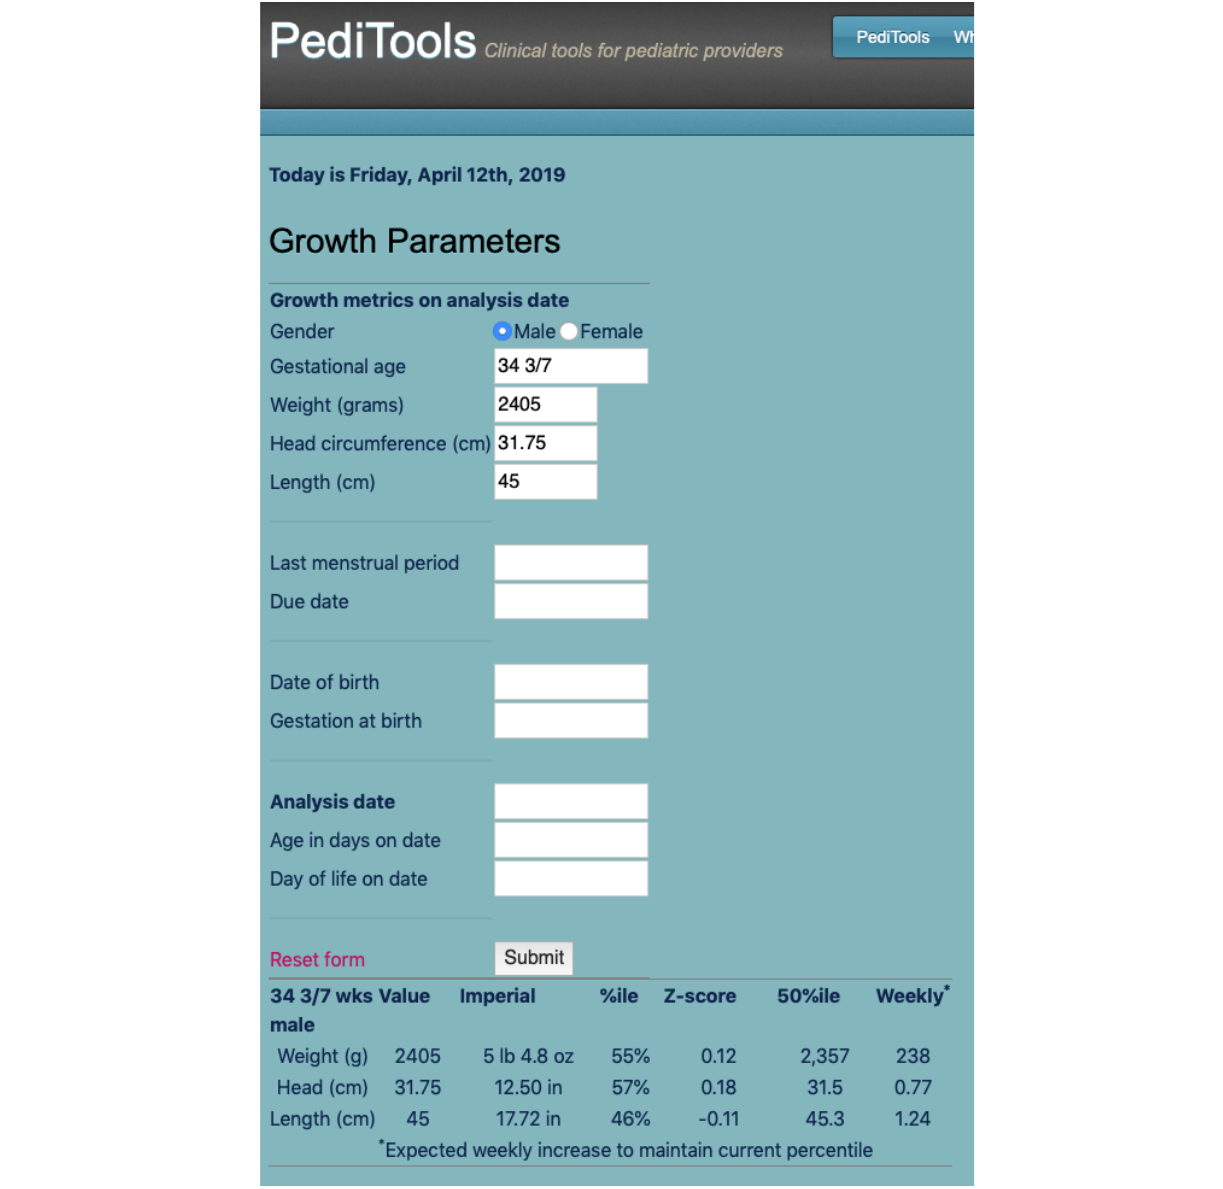
Figure 2. Screenshot of a representative PediTools web-based growth calculator (Fenton 2013 for preterm infants). The upper section demonstrates flexible support for multiple methods of input data entry. Data entry can include age as either gestational age or specific dates; measurements can be entered in metric or imperial units (grams or pounds and ounces; centimeters or inches); and even if no measurement is entered, the expected median (50th percentile) values will be displayed. The lower section displays the results of the LMS-based calculations, including the anthropometric measures in both metric and imperial units, percentile, Z-score, expected median measurement for age, and weekly growth required to maintain the current